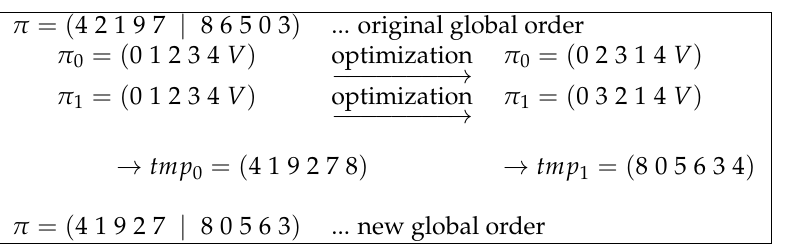
Figure 7. Example of mapping optimization information from two segments back to global permu- tation vector π . The virtual points V in π s correspond to the index 5 in this example. See text for further